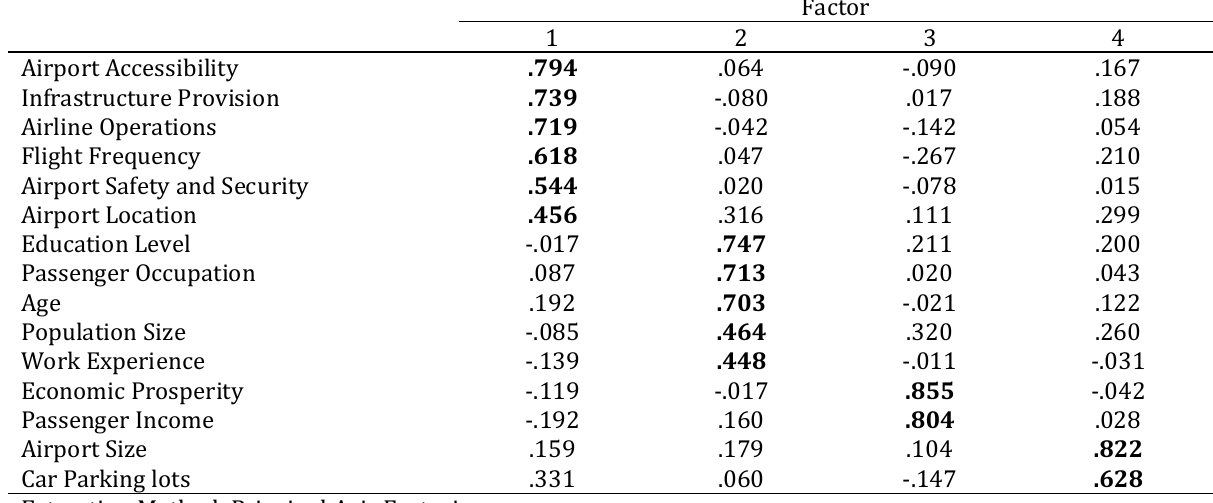
Table 10: Rotated factor matrix of domestic air traffic in Nigeria